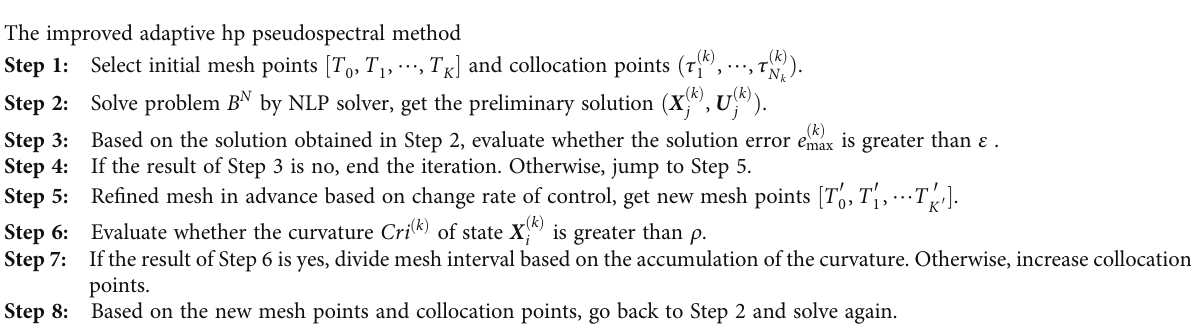
Algorithm 1: The description of the proposed